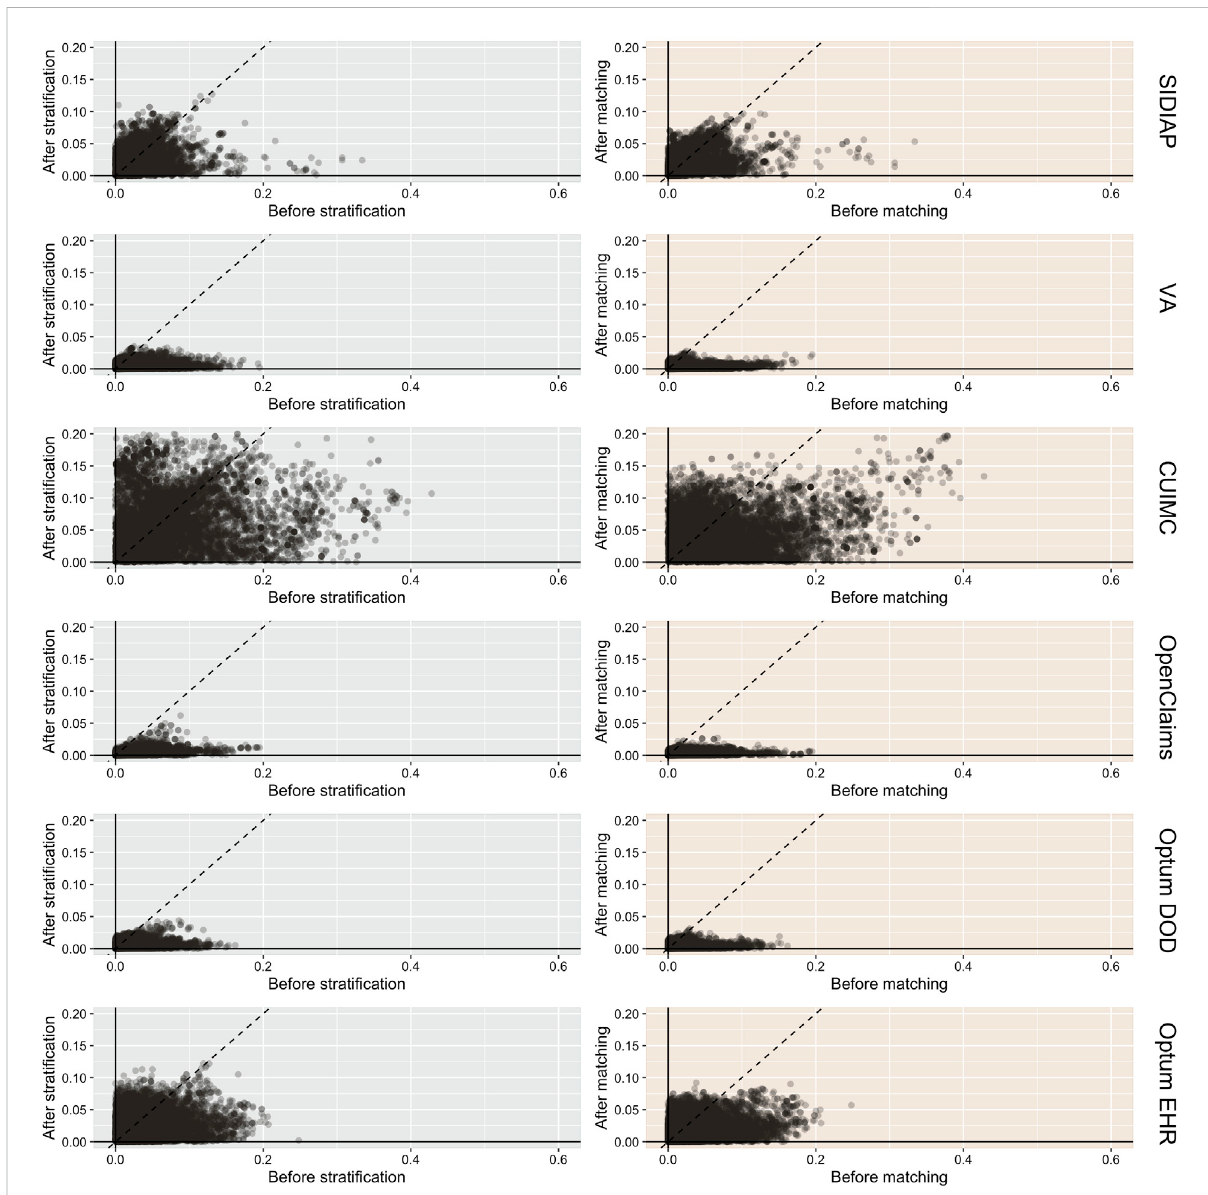
FIGURE 2 Cohortbalancediagnosticscomparingalpha-1blockerand5ARI/PDE5prevalentusers.WeplottheabsoluteSMDofpopulationproportionsfor all available patient characteristics(13,950 inSIDIAP, 81,436 inVA, 24,807 inCUIMC,73,113inOpenClaims, 79,184, inOptum DOD, 40,621inOptum EHR) before and after propensity score strati fi cation or matching across data sources. CUIMC fails study diagnostics under both strati fi cation and matching since the absolute SMDs are not consistently < 0.1. SIDIAP and Optum EHR fail study diagnostics under strati fi cation